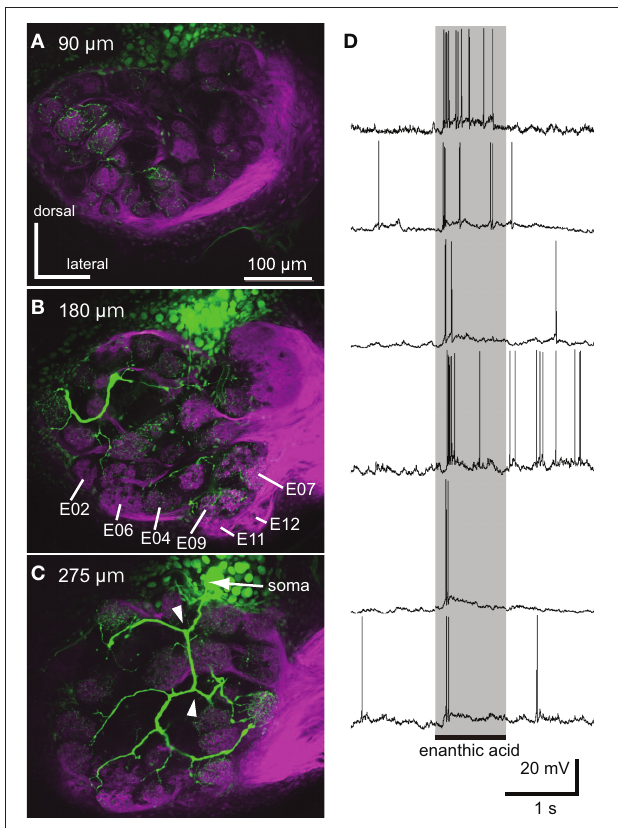
FIGURE 7 | Neural activities of single local interneuron innervating multiple glomeruli. (A–C) Serial optical sections, from anterior to posterior, of a typical enanthic acid-responsive local interneuron. The depths from the anterior surface of the AL are shown in upper left. The local interneuron innervates most, but not all, glomeruli in the cockroach AL (green). The neuron innervated the glomeruli in which enanthic acid-induced synchronized potentials were evoked ( B , Figure 5 ). The axons give rise to y-shaped branches (arrowheads in C ), which have been identified as GABAergic local interneurons (Husch et al., 2009b). Magenta: sensory afferents. (D) Phasic excitatory on-responses of local interneurons to enanthic acid. We recorded from 38 oligoglomerular local interneurons and 15 of them were enanthic acid-responsive. Six typical local interneurons innervated different sets of glomeruli exhibited phasic on-responses to enanthic acid stimulation (shaded phase). Similar response patterns were observed in all local interneurons that were recorded